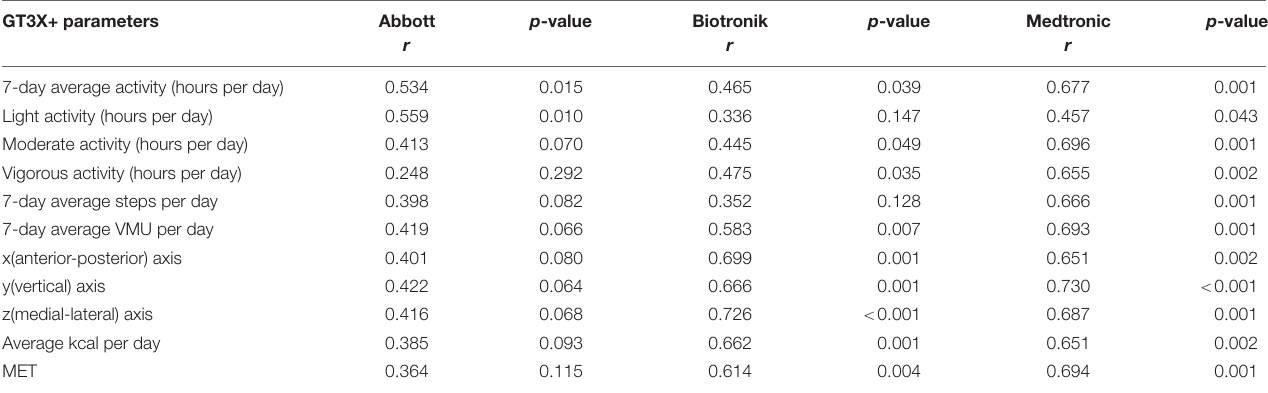
TABLE 3 | Correlations between cardiovascular implantable electronic device-measured physical activity and Actigraph GT3X+ parameters. GT3X+ parameters Abbott p -value Biotronik r